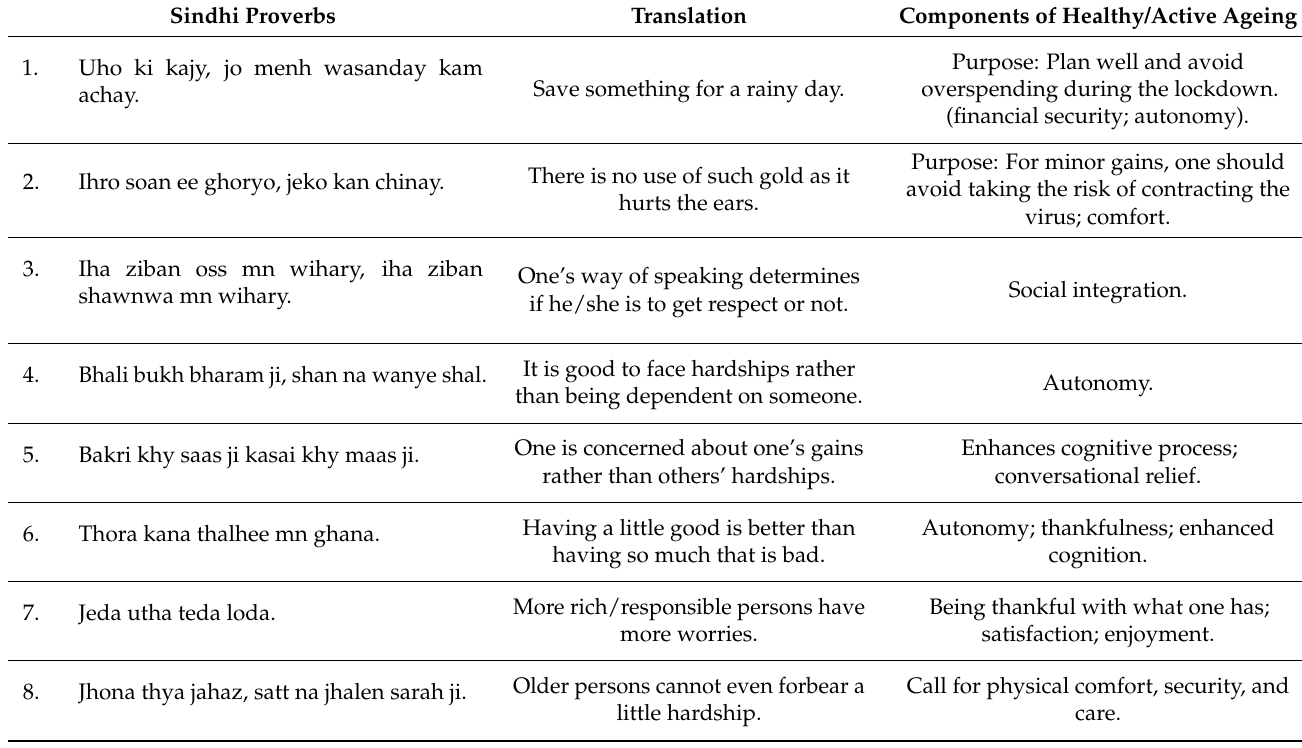
Table 4. Proverbs used by the participants in their